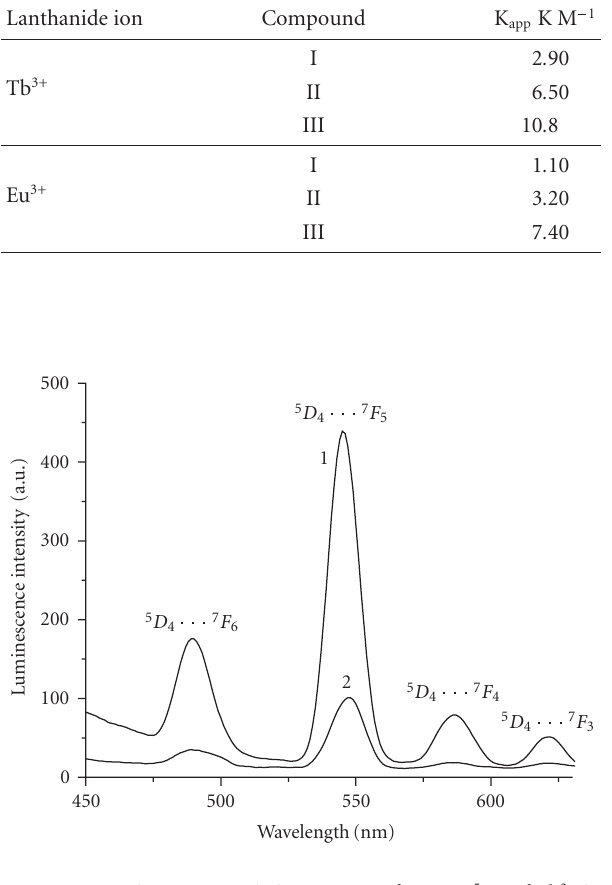
10 (cid:0) 5 M of Tb 3+ in (cid:0)